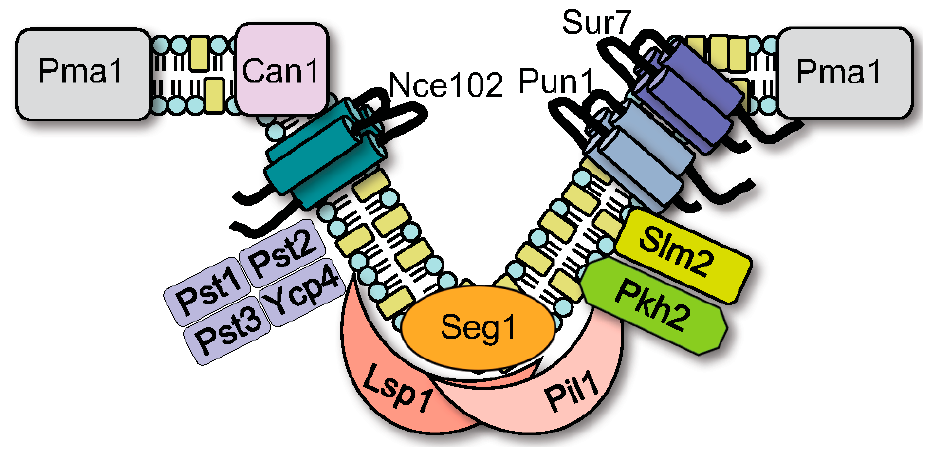
Figure 2. Model for MCC/eisosome structure. Representatives of the approximately 30 proteins that localize to MCC/eisosomes in S. cerevisiae are shown.